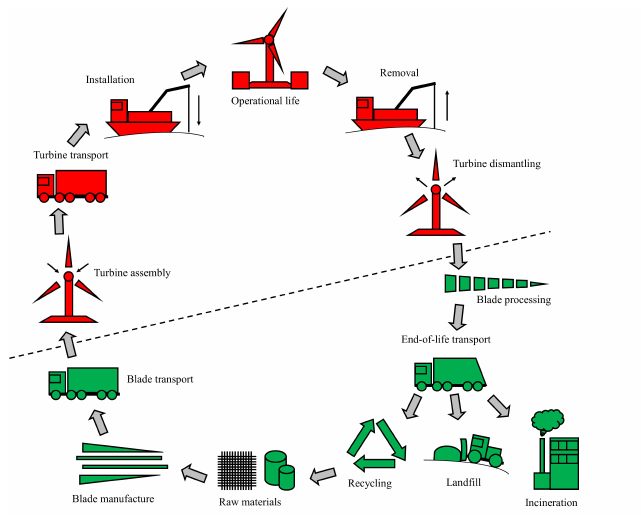
Fig. 1. Life cycle diagram for turbine blade illustrating stages included (green) and excluded